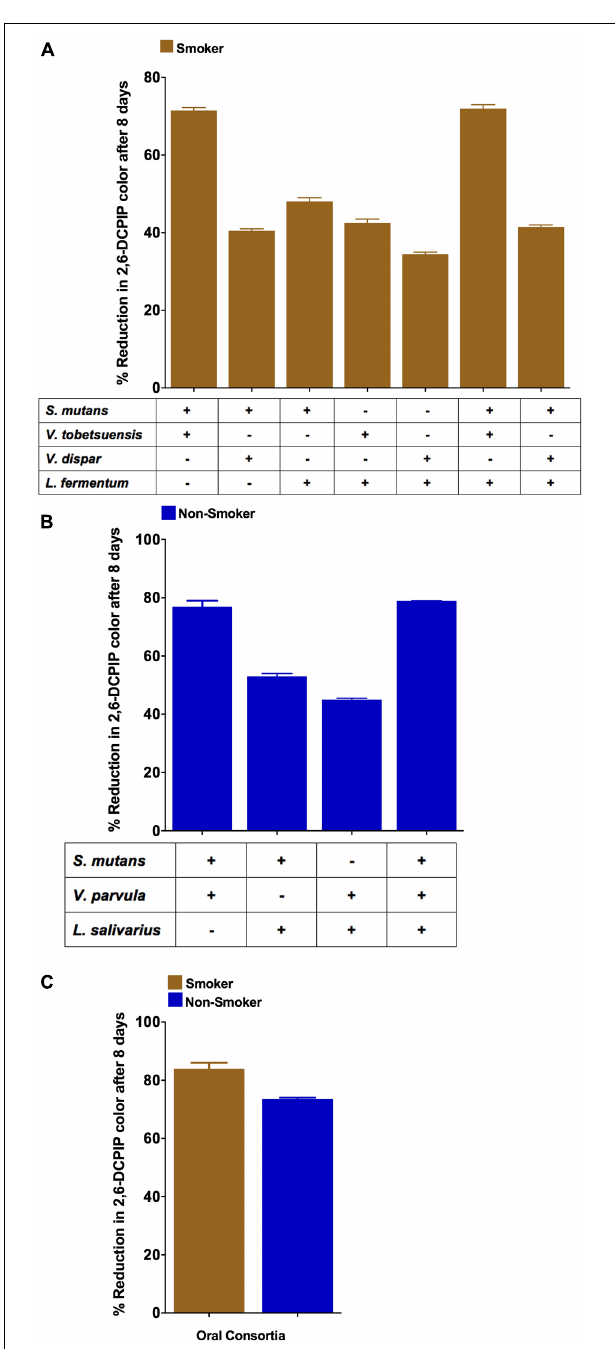
FIGURE 6 | Anthracene biodegradation represented as DCPIP color intensity % by S. mutans , Lactobacillus spp. and Veillonella spp. mixtures after 8 days in smokers and non-smokers. (A) Duos and triples mixtures from smokers; (B) Duos and triples mixtures from non-smokers; (C) Consortium from representative smokers and